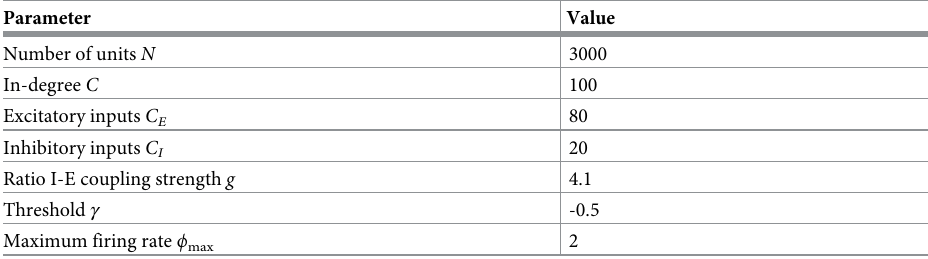
Table 1. Parameter values used in the